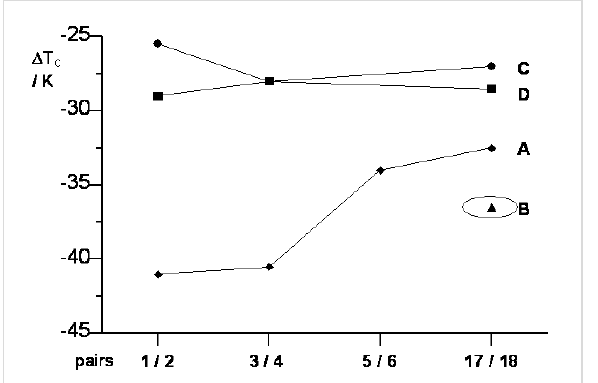
Figure 5: The change in the clearing temperature Δ T c upon substitu- tion –OCH 2 – → –CH 2 CH 2 – in selected pairs of compounds. The lines are guides for the eye.